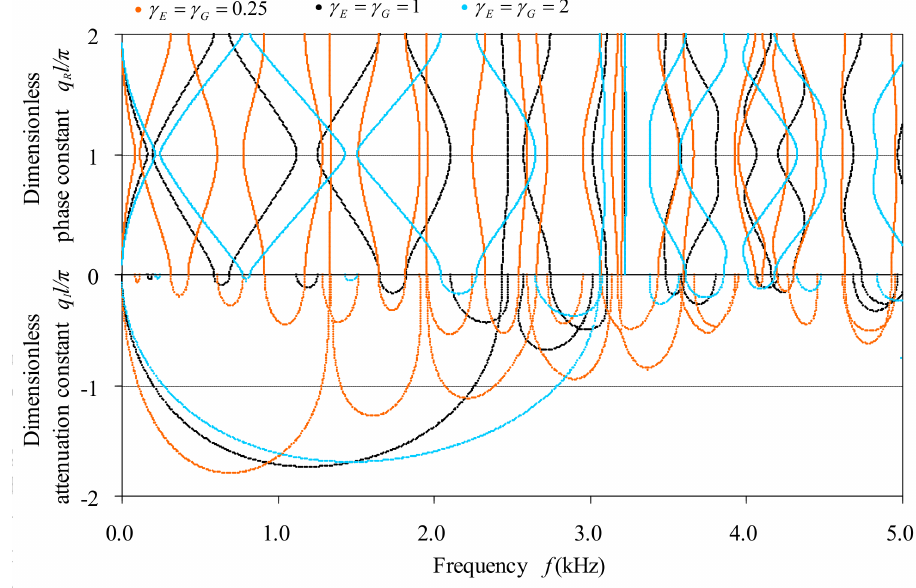
Figure 11. Effect of the modulus of constituent beam as its Poisson’s ratio remains on the band structures in the bi-coupled periodic beam with Ternary-I unit cell.